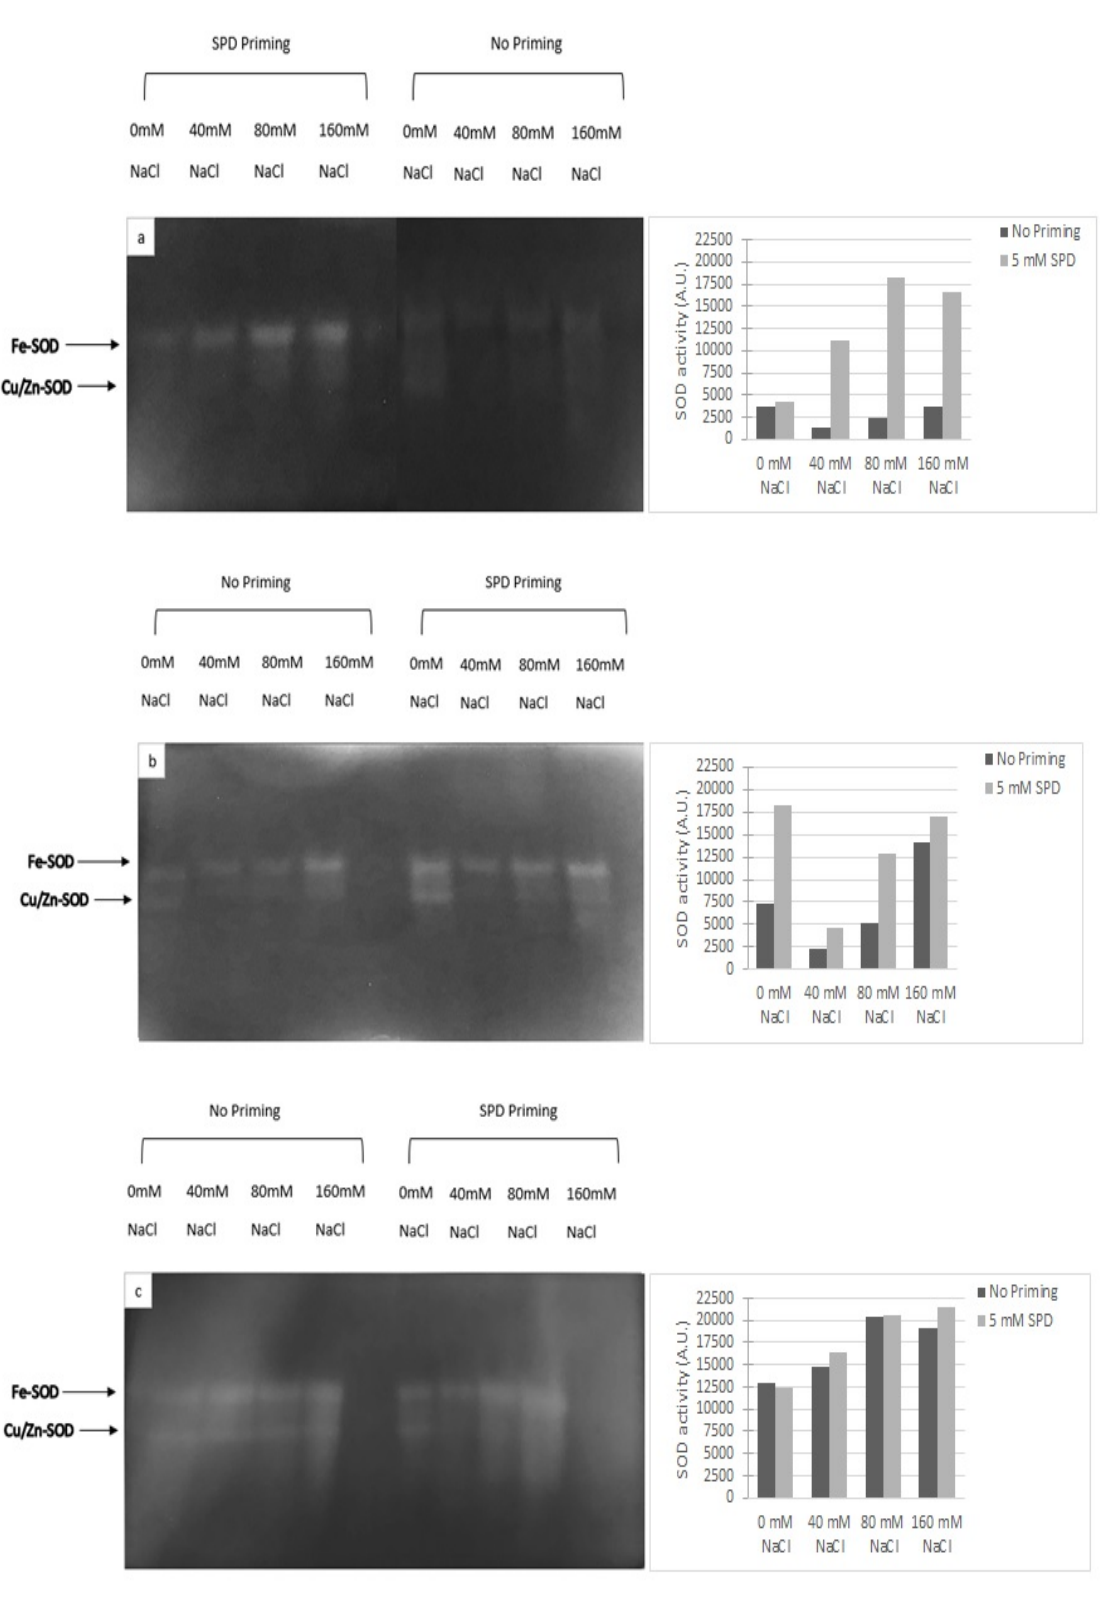
Figure 3. Effect of spermidine priming on SOD activity of rapeseed cultivars exposed to saline conditions (( a ): Sy Saveo, ( b ): Edimax, ( c ): Dynastie).